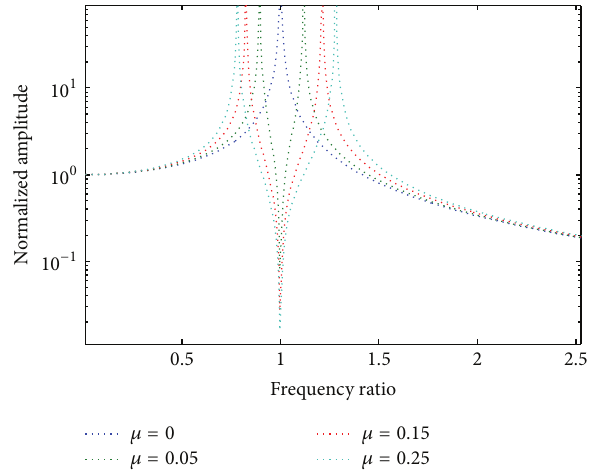
Figure 5: Normalized magnitude of primary mass versus normal- ized driving